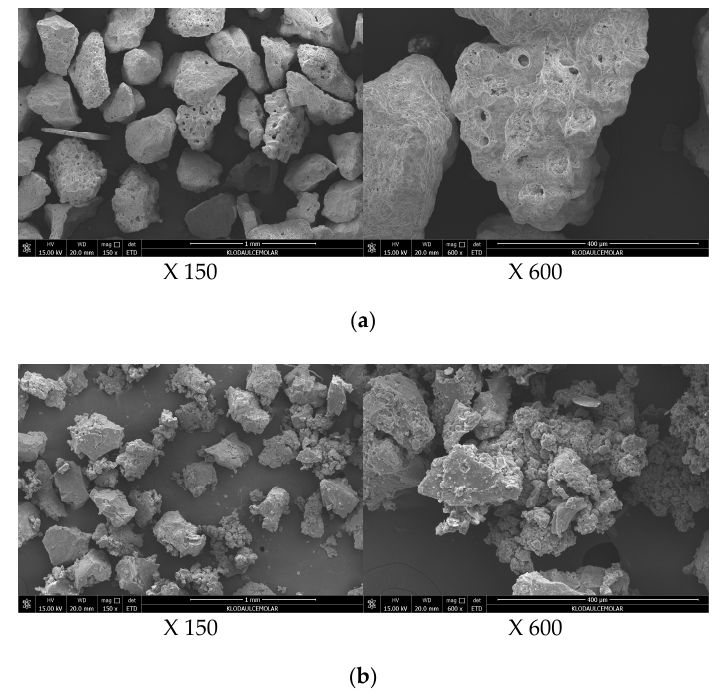
Figure 1. Micro-scale image of the test materials: ( a ) Calcareous sand; ( b ) rubber chips.